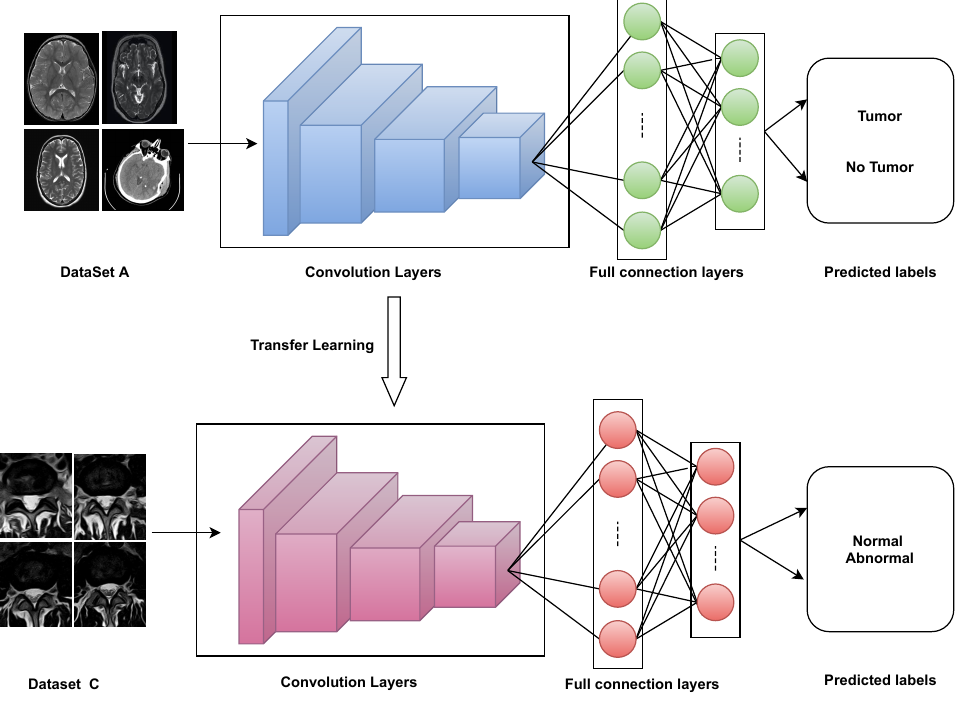
Figure 13. Transfer learning from the training model from scratch with Dataset A (labeled brain tumor MRI